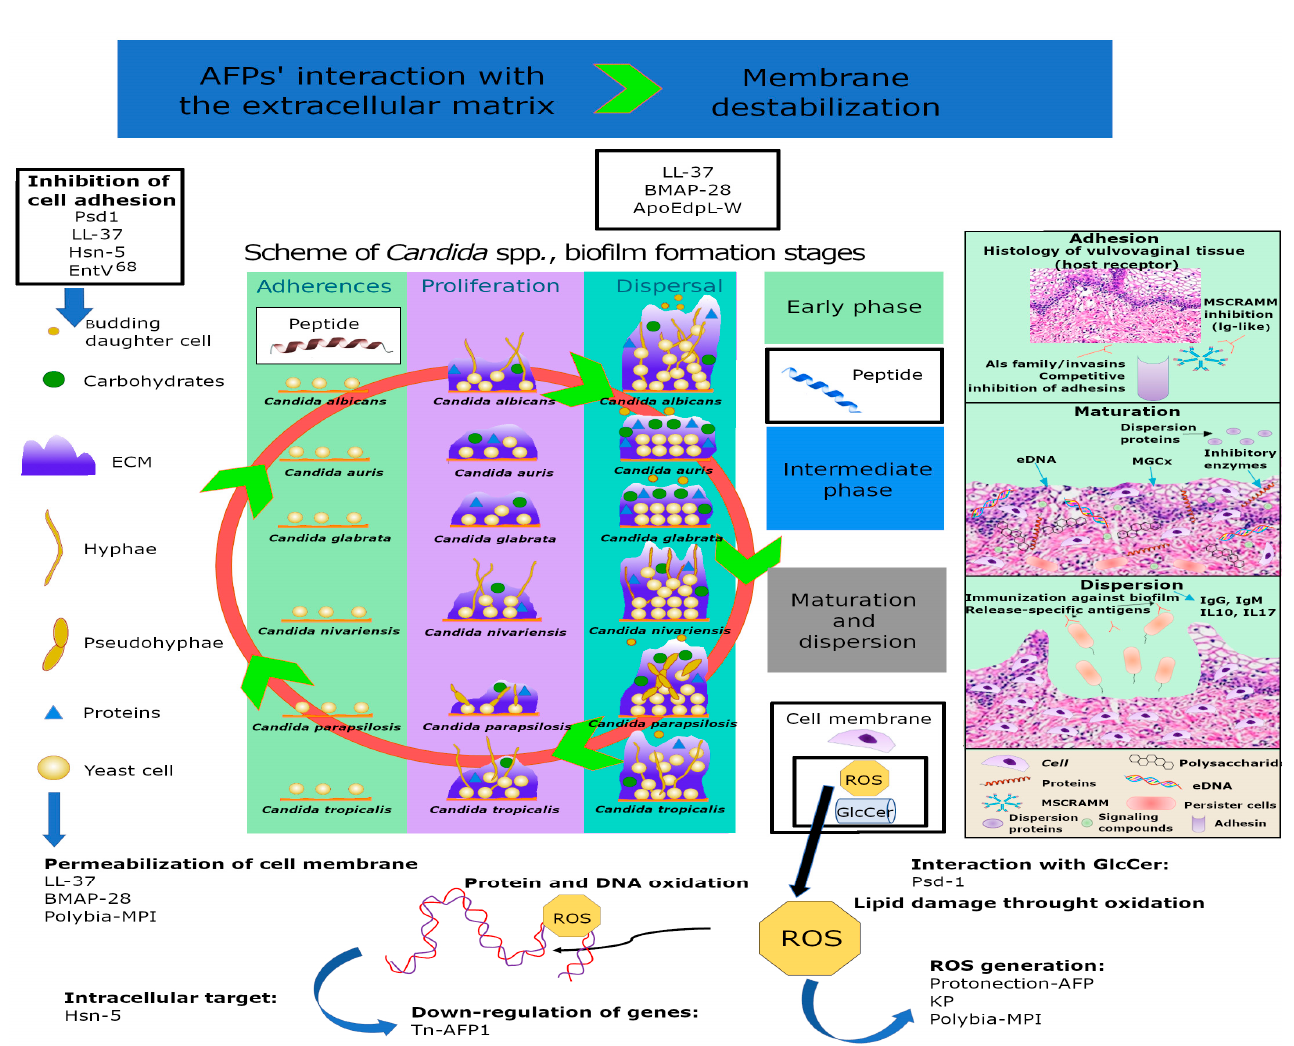
Figure 2. Drawing of the di ff erent antifungal peptide origins.